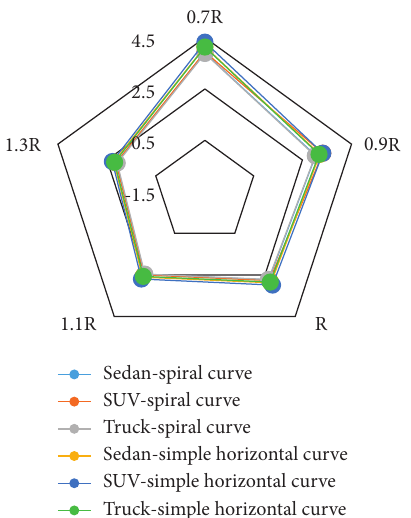
Figure 22: Maximum yaw rate in the simple and spiral horizontal curves for various radii and vehicle types at the speed of 100km/h.